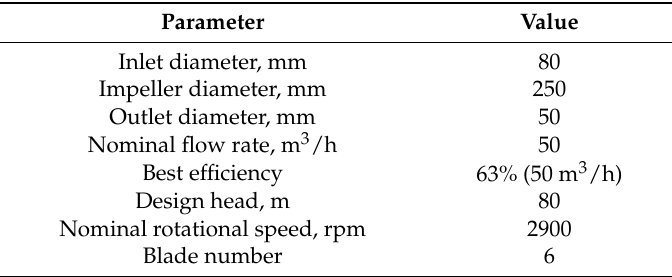
Table 2. Measurement characteristic of instruments.